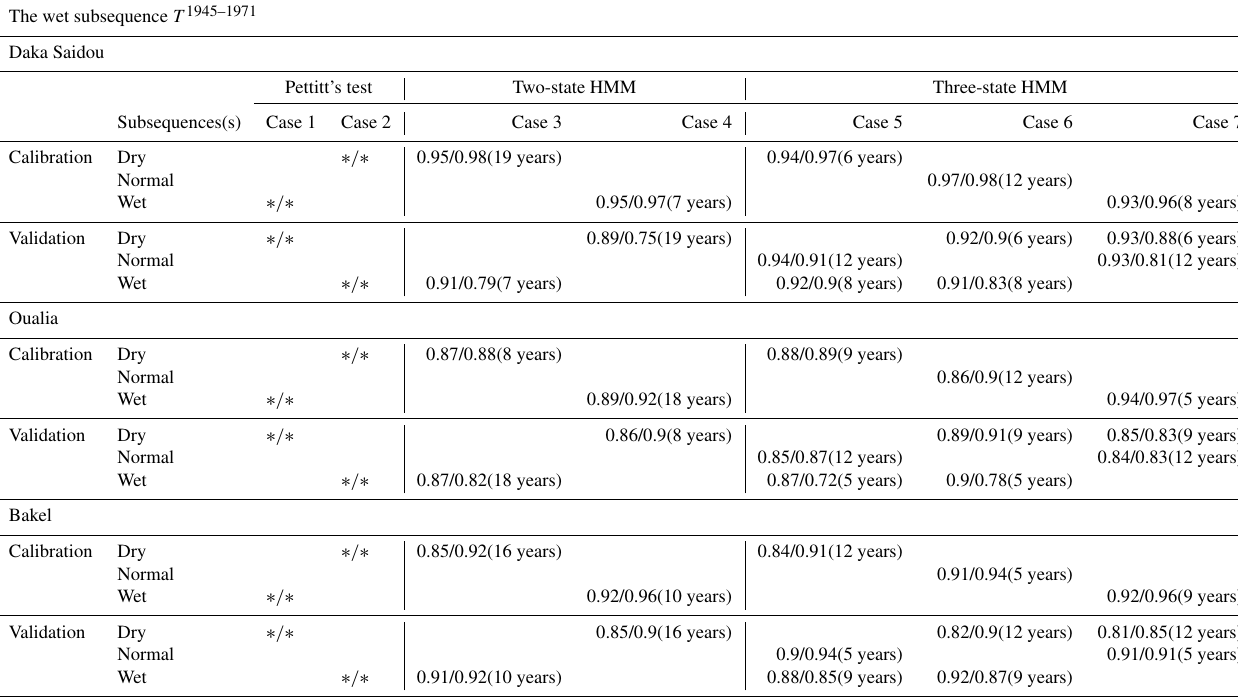
Table 5. Table of NSE/KGE calibration and validation scores according to the seven cases for the wet subsequence T 1945–1971 . As Pettitt’s test is not conclusive here, no calibration/validation scores are given (symbols ∗ / ∗